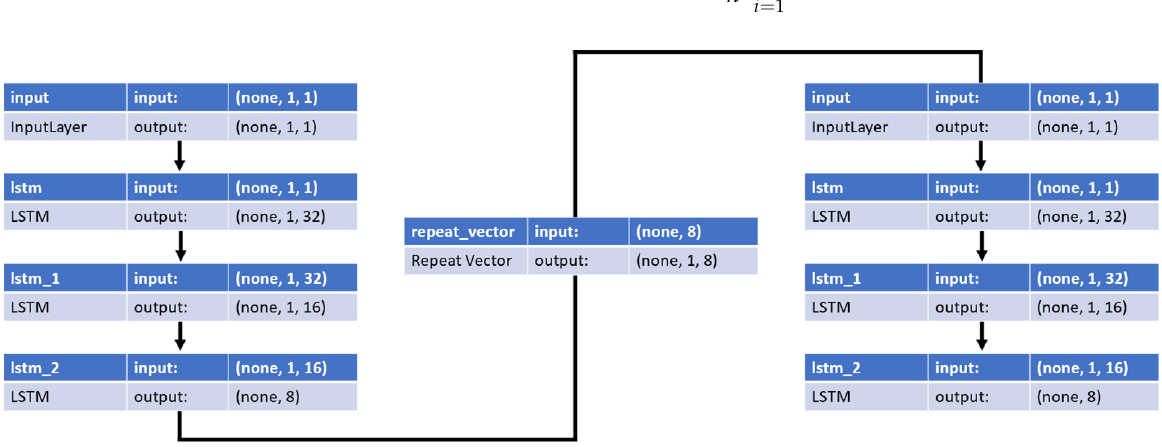
Figure 14. Structure of the LSTM autoencoder model.